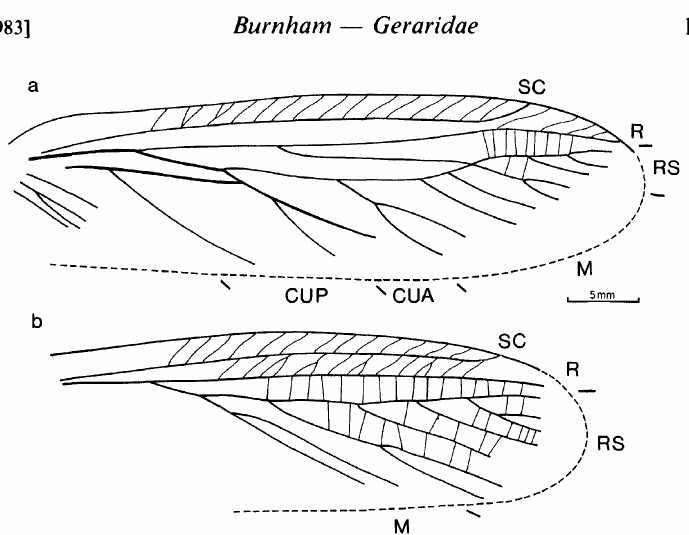
Fig. 4. Gerarus vetus, a. composite drawing of the fore wing, based on DGLS and USNM 38136. b. composite drawing of the hind wing, based on DGLS and USNM